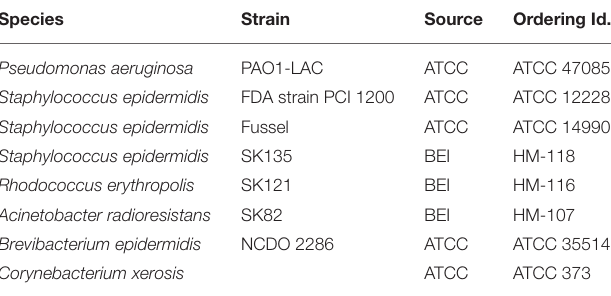
TABLE 1 | Bacterial strains and ordering information. Species